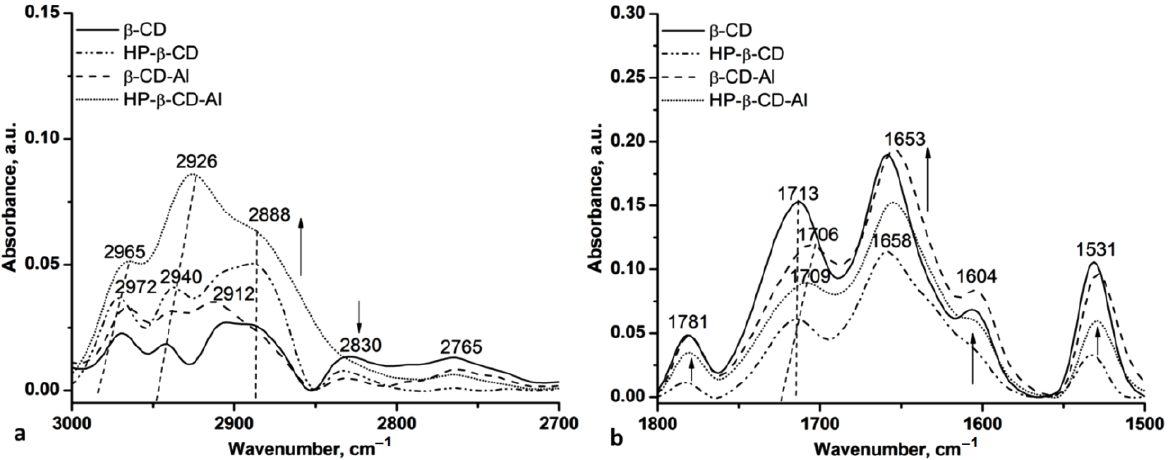
Figure 2. The C-H ( a ) and carbonyl, amide II ( b ) regions of β -CD, HP- β -CD and their inclusion complexes with allantoin (1:1).